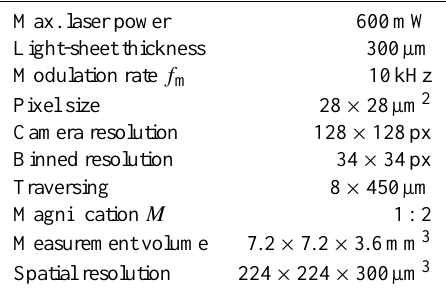
Table 1. Specifications of the measurement system including the laser and the high-speed